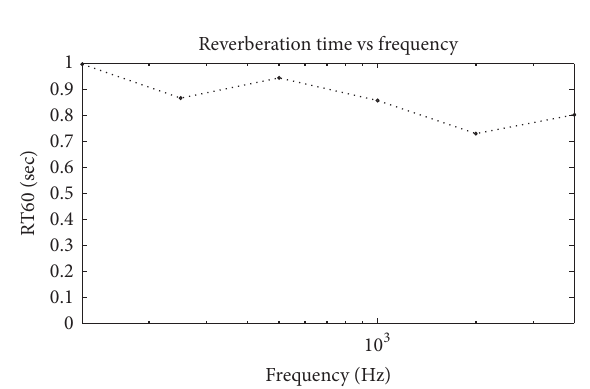
Figure 5: The reverberation time versus frequency for the simulated